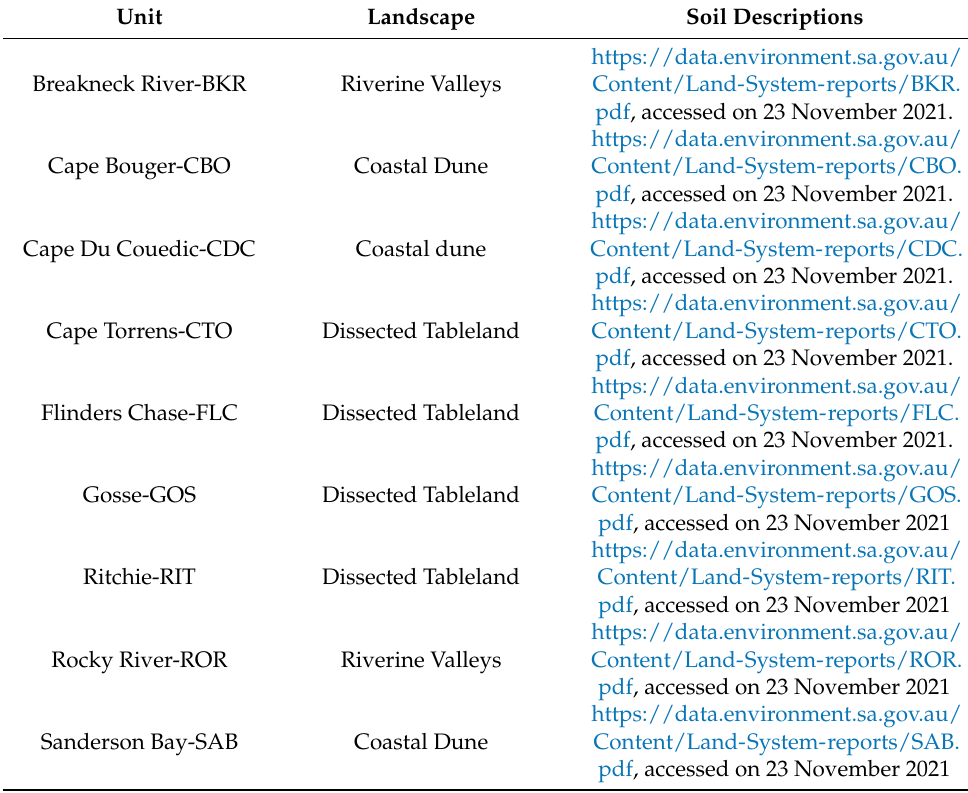
Table A1. Showing the Landsystem (LS) Unit used to compare fire severity in Figures 5 and 9. All descriptions are available at https://data.environment.sa.gov.au/, accessed on 23 November 2021.